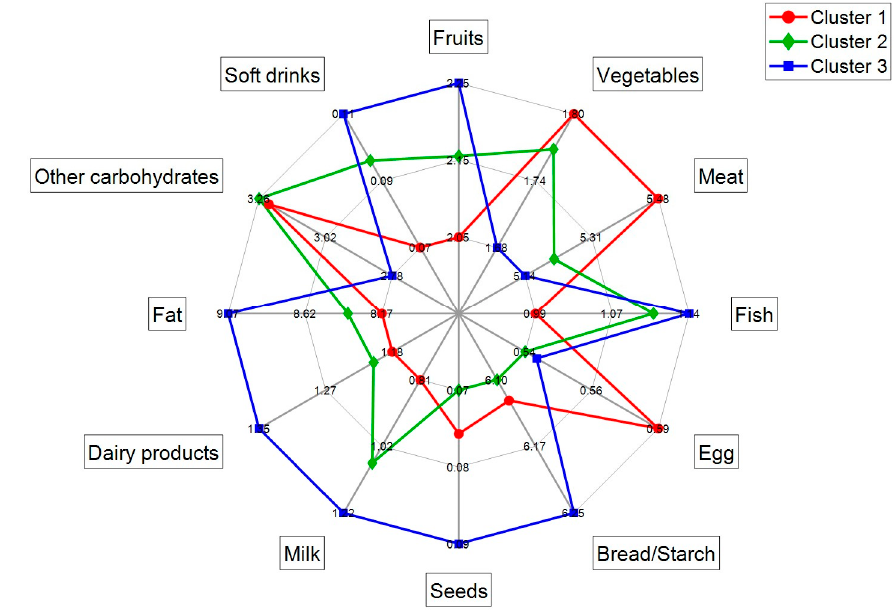
Figure 5. Mean R24h food group values for clusters 1 to 3.